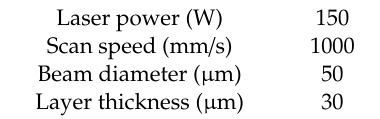
Table 2. Selective laser melting (SLM) process parameters used for stainless steel